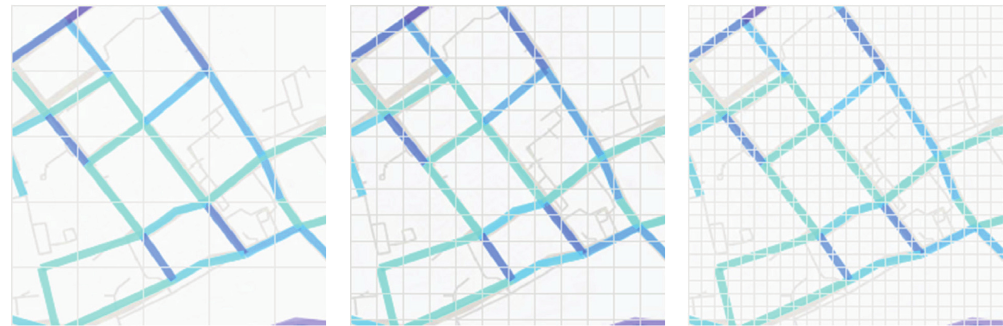
Figure 4: Gridding with different densities.